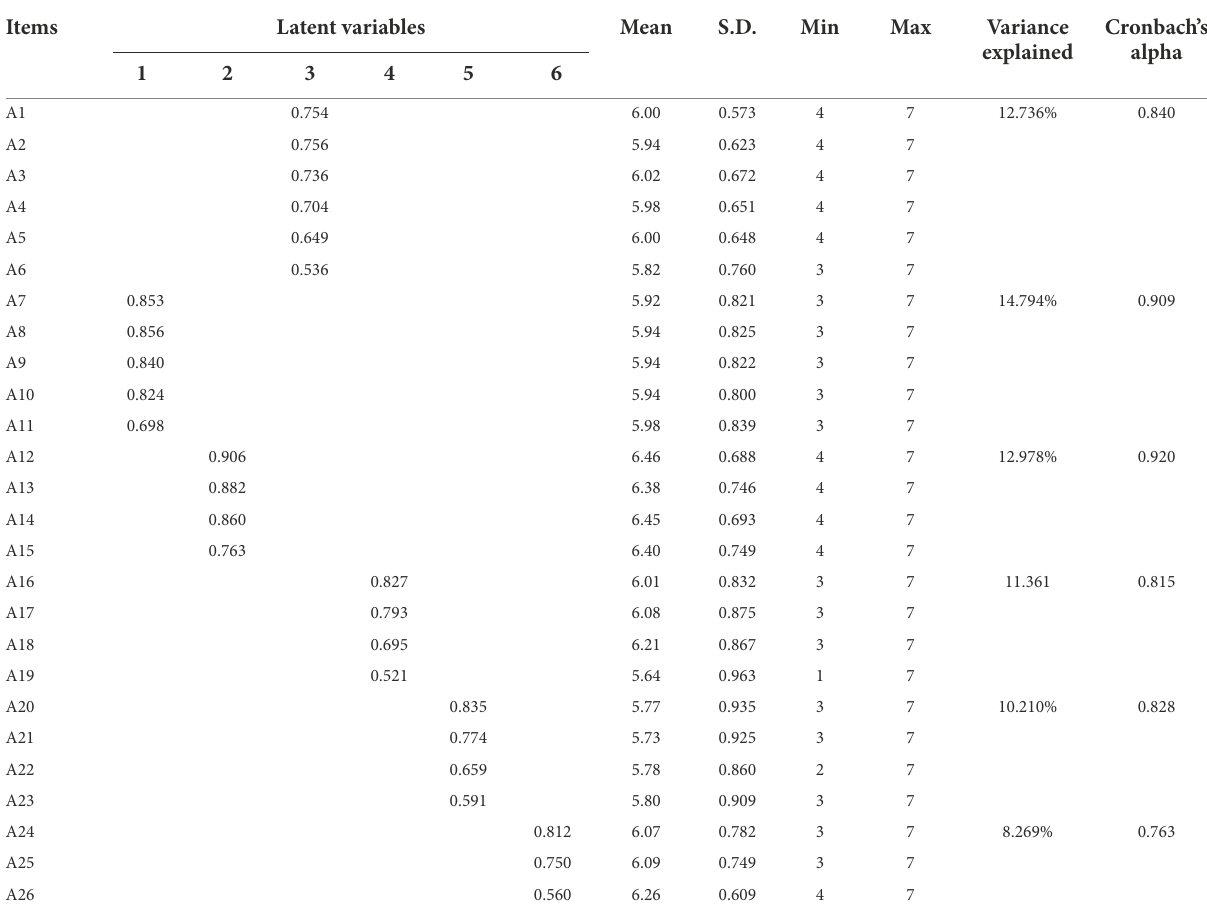
TABLE 2 The results of EFA ( n = 233).